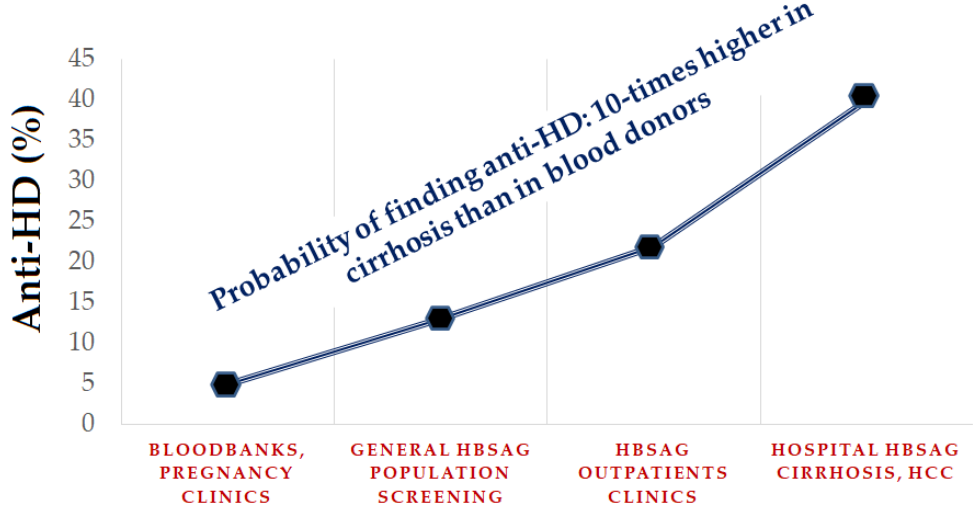
Figure 3. Prevalence of anti-HD in HBsAg carriers at low and high risk of HDV recruited at different sites (extrapolated from data in Italy in the 1980s). Abbreviations: anti-HD, antibodies to hepatitis D; HCC, hepatocellular carcinoma.